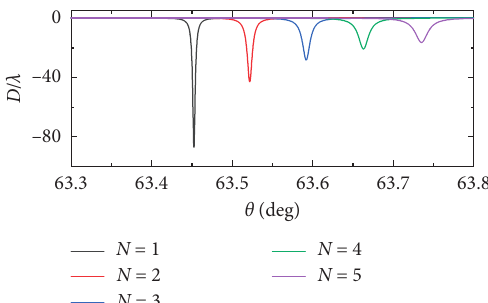
Figure 4: Relationship between the GH shift and incident angle at different number of layers of